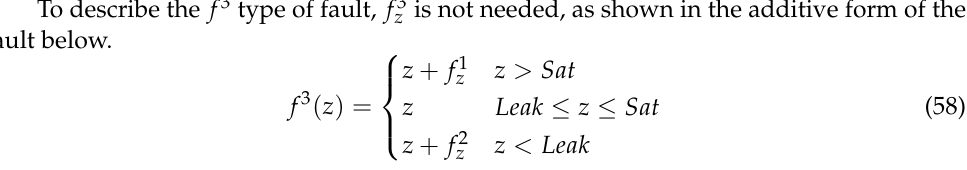
Figure 1. Three-pond hydraulic